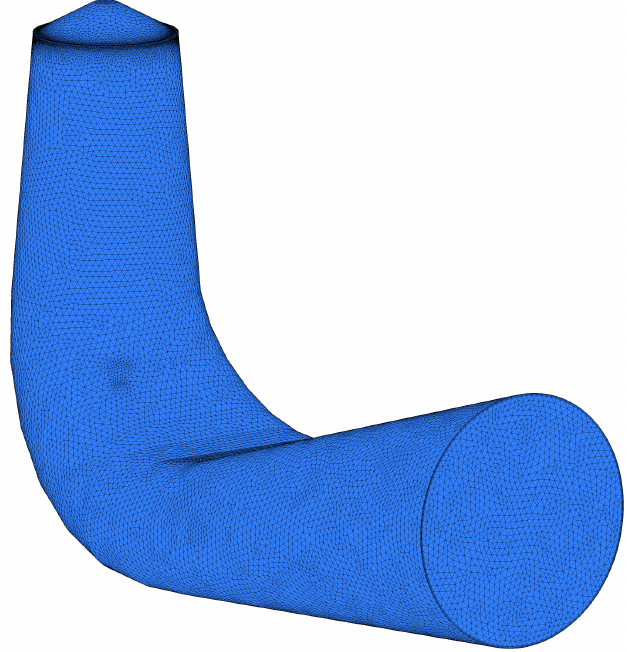
Figure 7. Mesh of the draft tube